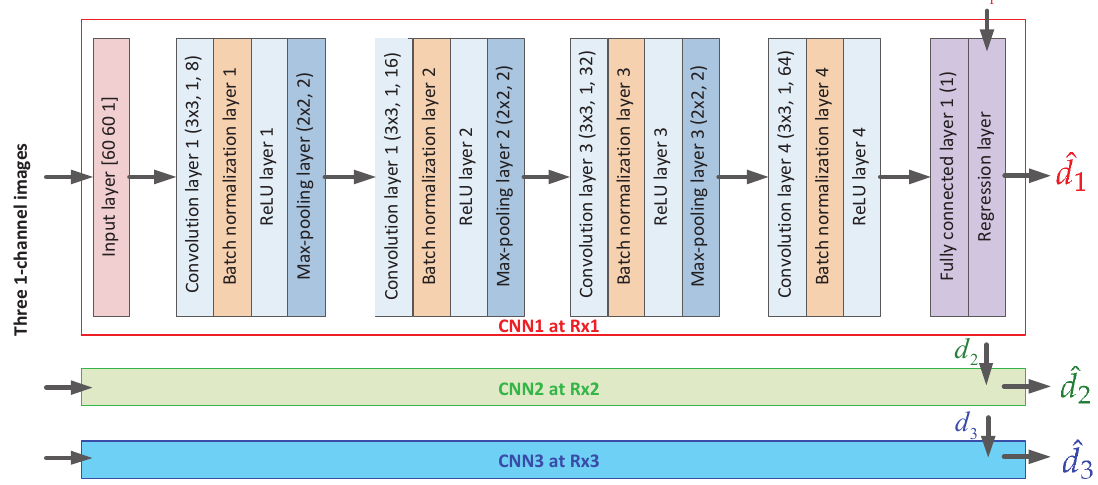
Figure 3. Structure of CNNs for the CNN-DE method. Each Rx requires CNN, and thus, three CNNs are required for the CNN-DE